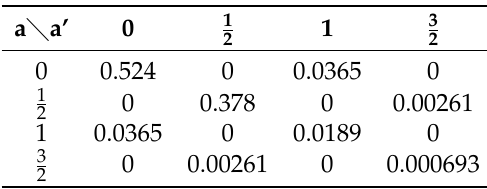
Table 2. Probabilities to find an ( k = 3 ) anyon ( a , a (cid:48) ) for the fusion product of two plaquettes in the ( ˜k = 2 ) -vacuum